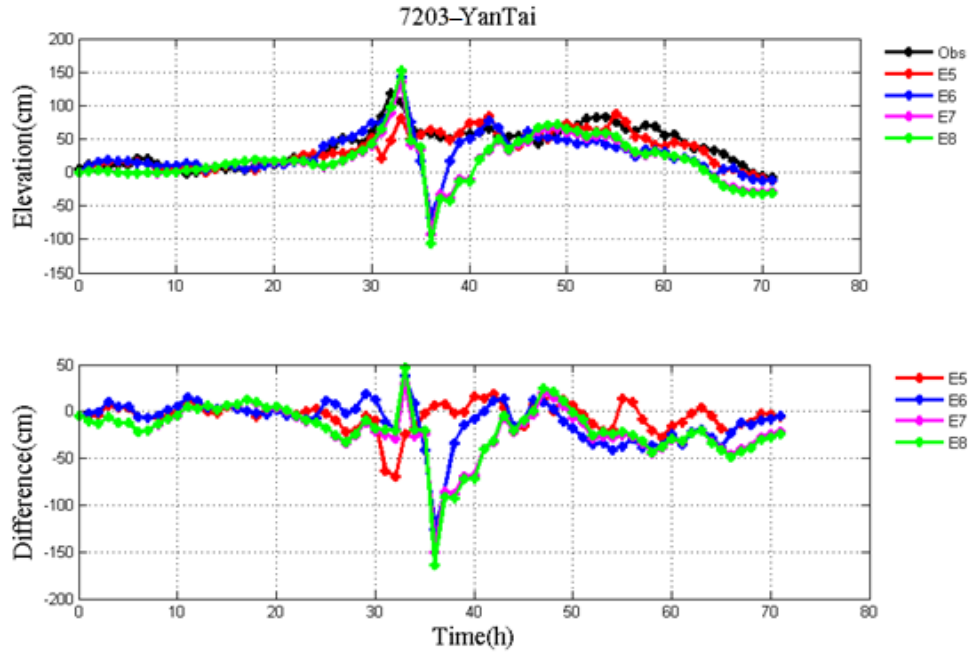
Figure 10. Pure storm surge levels without the astronomical tides in E5 − E8, observation (black line) ( top ), and their differences ( bottom ) during Typhoon 7203 at YanTai station.